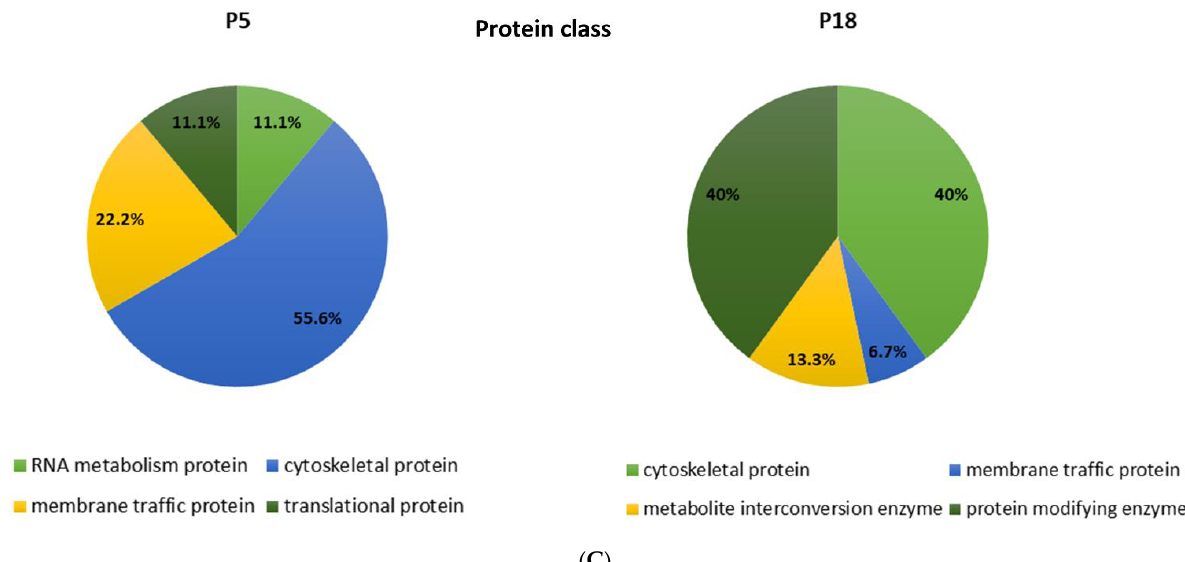
Figure 1. Functional classification of the proteins identified by MS as differentially distributed in the opossum P5 and P18 spinal cords. Proteins were classified based on assumed molecular function ( A ), biological process ( B ), or protein class ( C ).